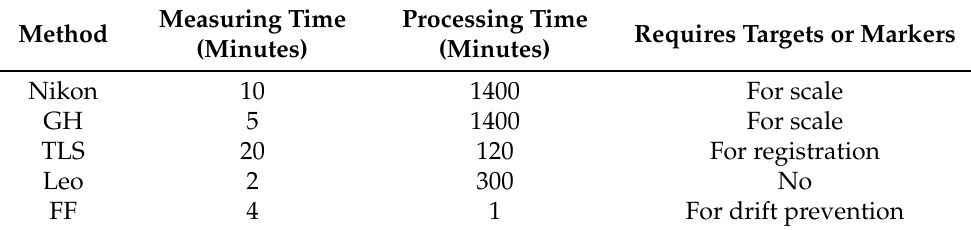
Table 16. Measurement and processing times and target requirements for each method. The numbers are approximate and referential, and real results will differ with